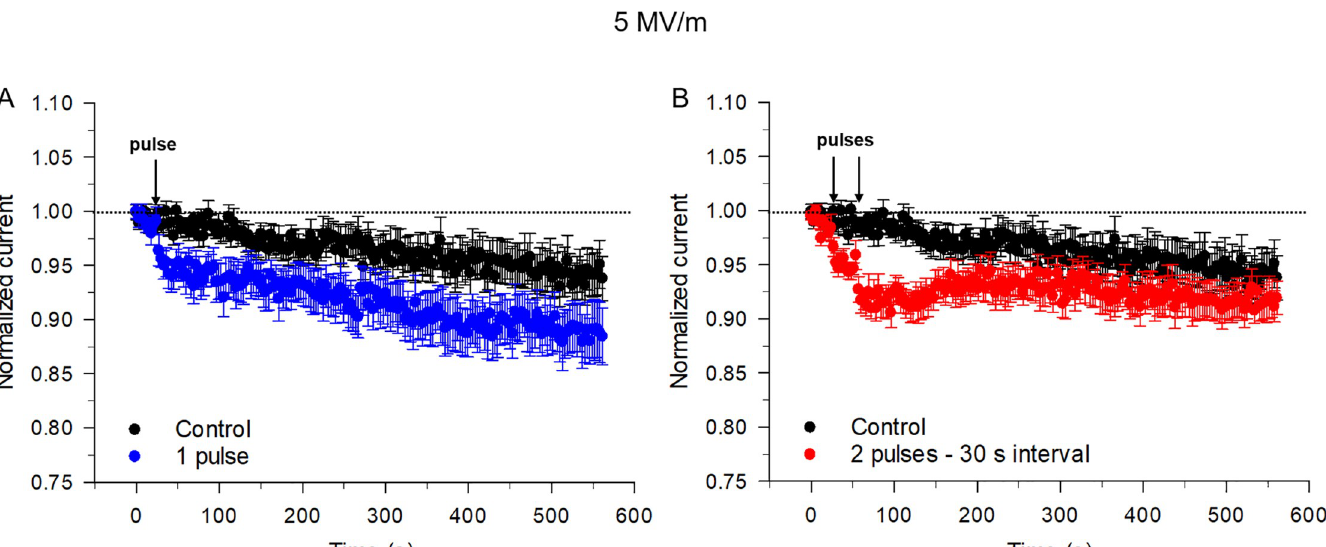
PLOS ONE | https://doi.org/10.1371/journal.pone.0234114 June 9,